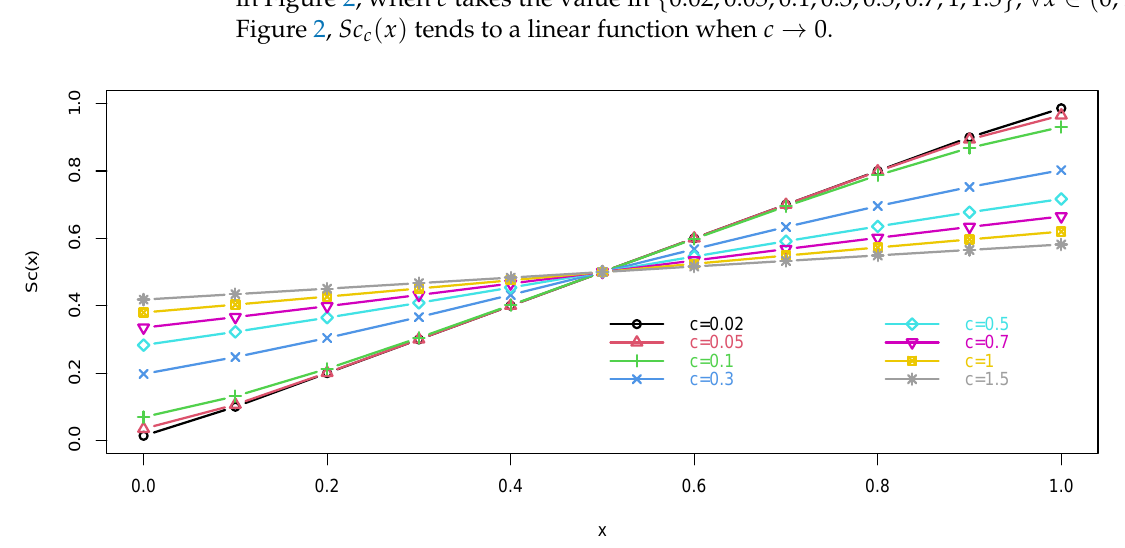
Figure 2. Plots of the soft-clipping